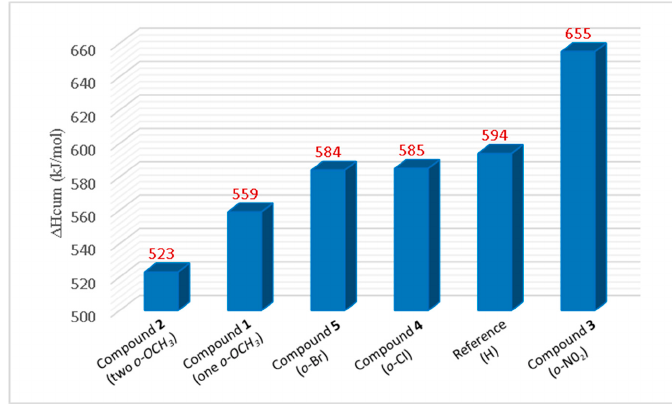
Figure 5. The cumulative total enthalpy ( Δ H cum ) of consecutive SPLET mechanisms.